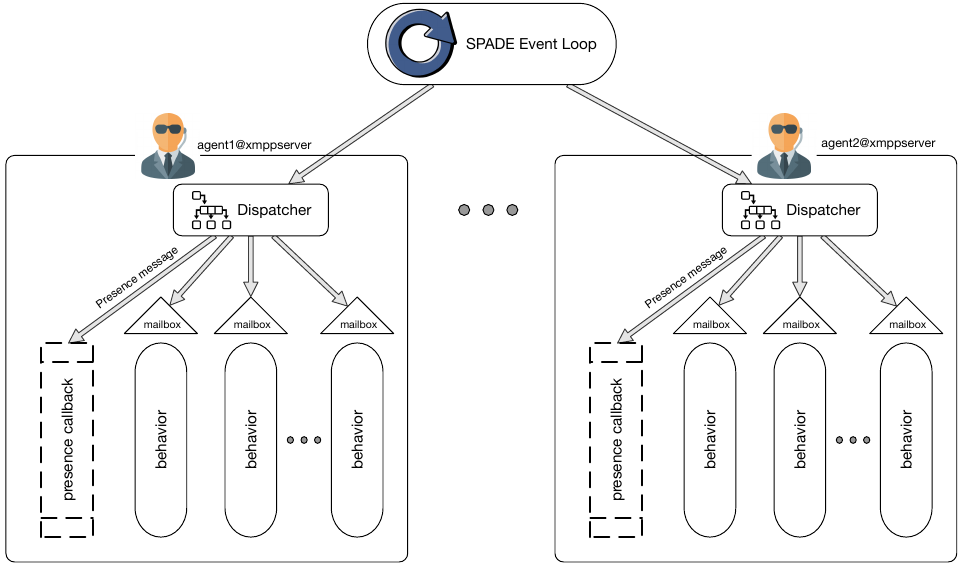
Figure 1. Internal architecture of a SPADE